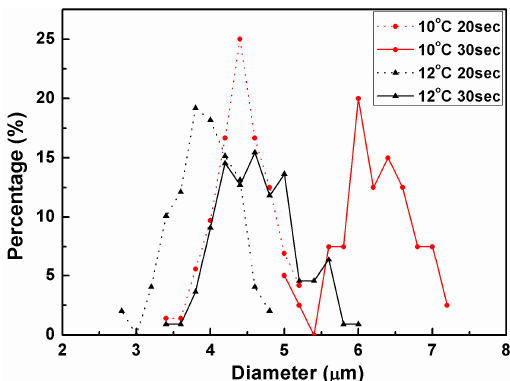
Figure 12. Size distribution of melting width of machined holes at 10 ∘ C and 12 ∘ C with a power density of 1.2 10 8 W/cm 2 .